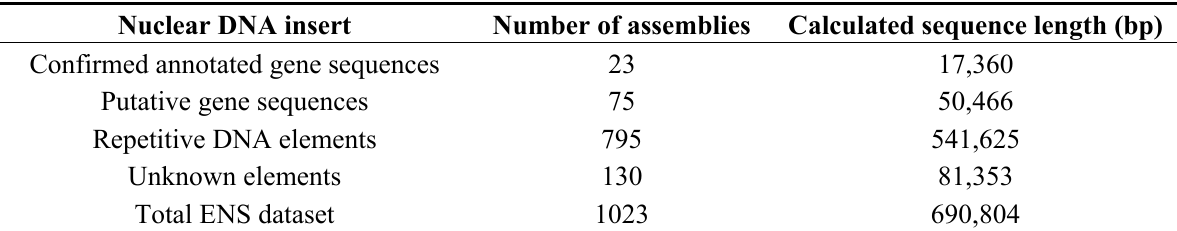
Table 2. Details of the sequence composition of nuclear DNA